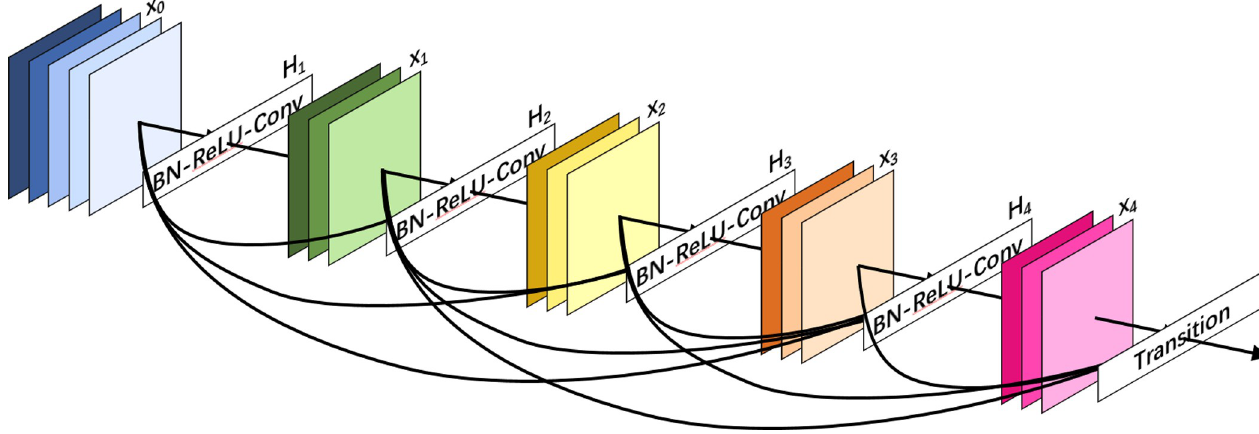
Fig 3. The dense block.